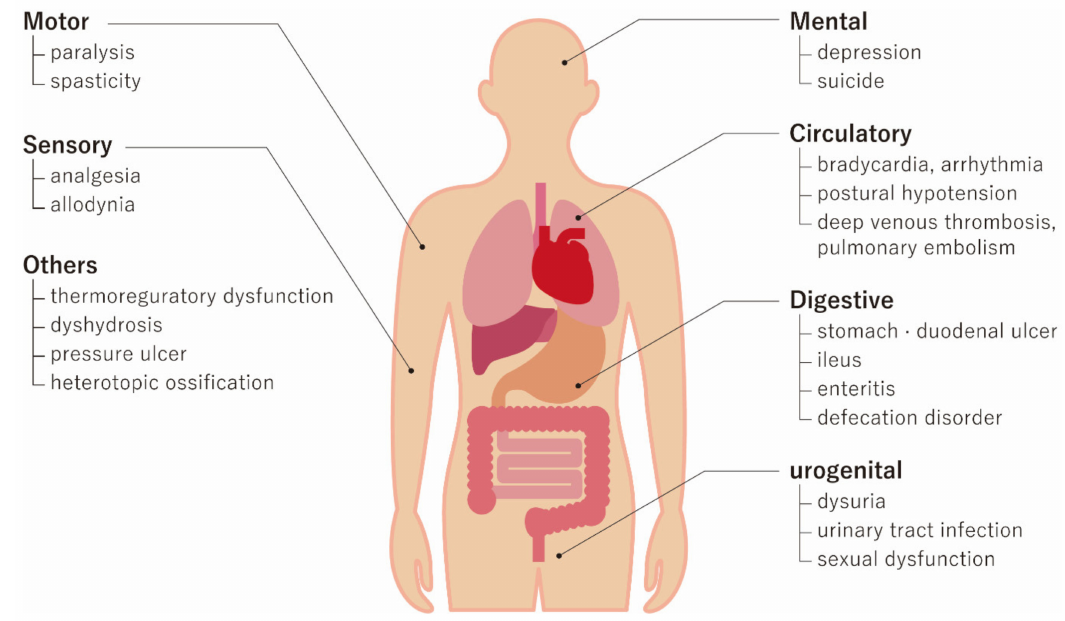
Figure 1. Systemic medical problems after spinal cord injury (SCI). SCI can cause motor functional deficits of paralysis and increased spasticity. Sensory disturbance includes severe analgesia below the level of injury and allodynia. SCI can also a ff ect su ff erers mentally by causing depression and possible suicide. Circulatory, digestive, and urogenital impairments need to be treated, as well as skin